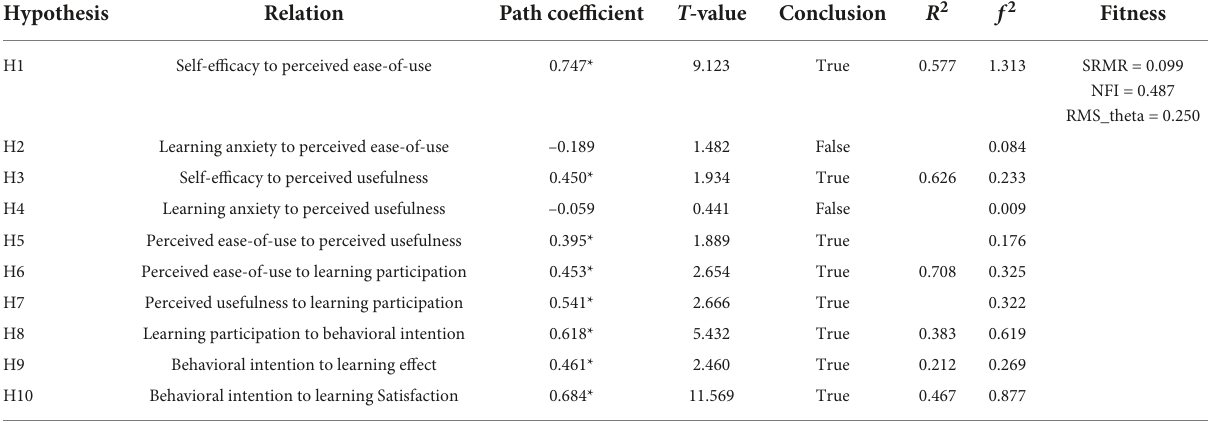
TABLE 7 The assessment and verification sheet for SPOC-AIoT scaling structure model.